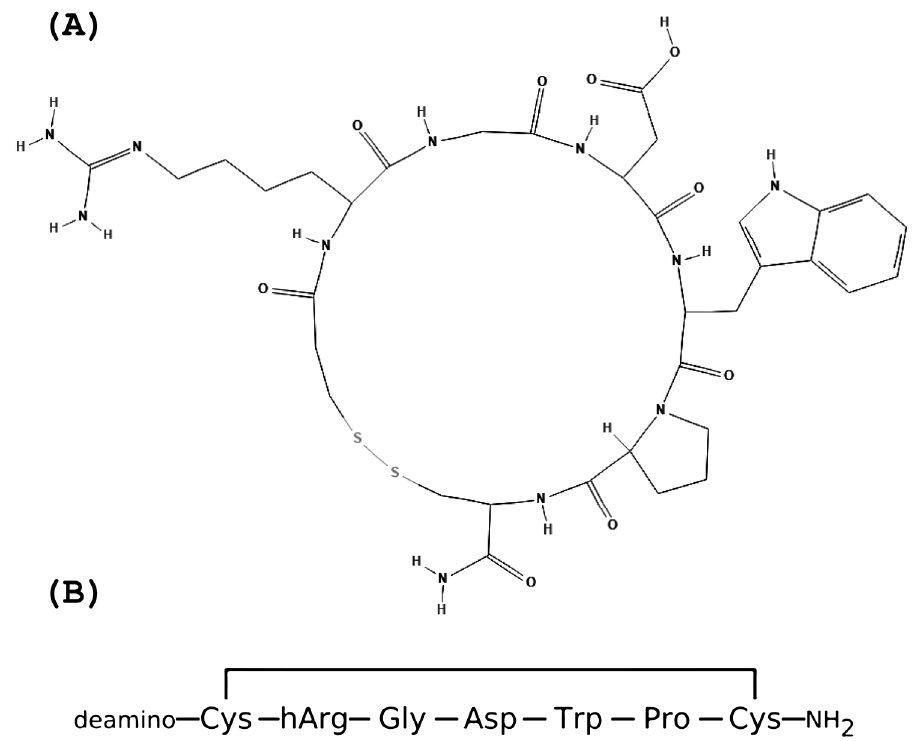
Figure 2. We present eptifibatide’s structure and amino acid sequence. Both were obtained from PubChem [63]. ( A ) Eptifibatide structure; ( B ) Eptifibatide amino acids